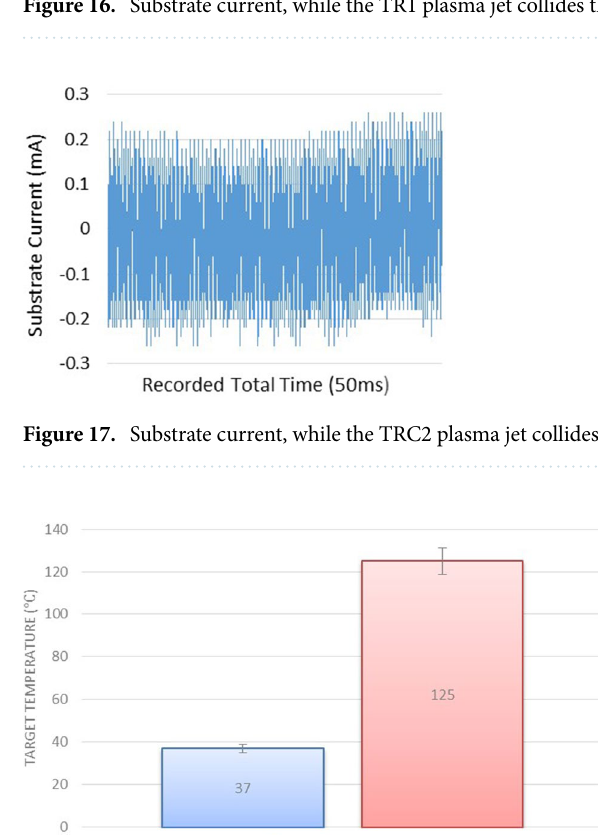
Figure 16. Substrate current, while the TR1 plasma jet collides the target.